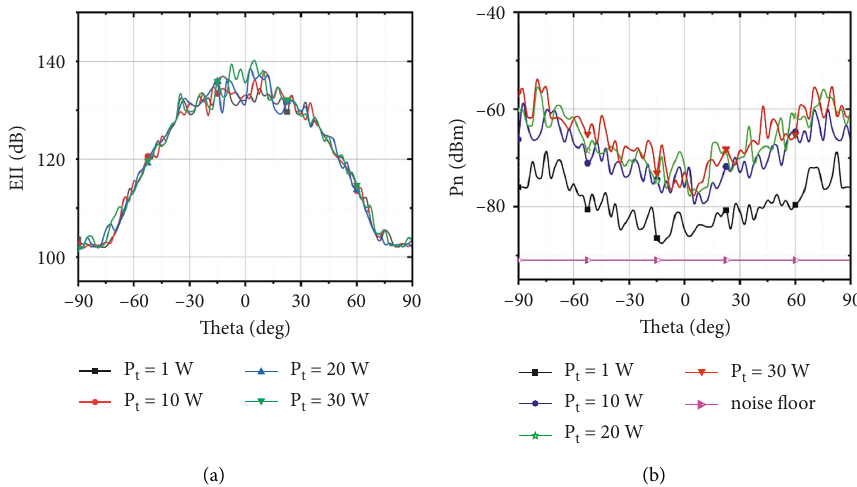
Figure 5: The performance of GA optimizes array partitioning at 10GHz. (a) The EII at different transmit power. (b) The P transmit